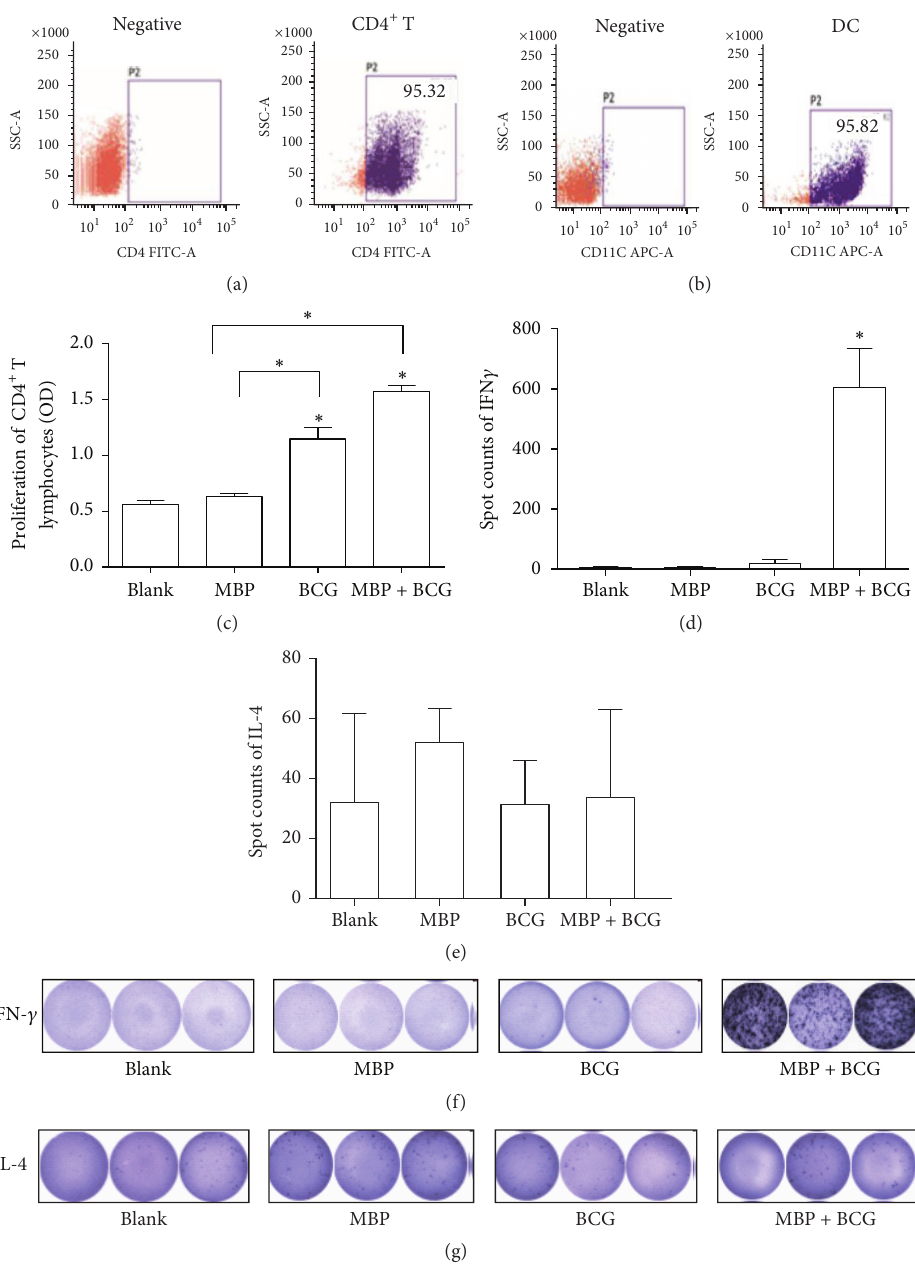
Figure 1: The activation of CD4 + T cells induced by the combination of MBP and BCG. (a) Isolation of CD4 + T cells from spleen samples from normal mice. The CD4 + T cell purity was analyzed by flow cytometry. (b) Dendritic cells were isolated from the spleen, and the percentage of dendritic cells purified was measured by FACS analysis. (c) MBP and BCG synergistically increased the proliferation of CD4 + T cells cocultured with DCs. All experiments were repeated three times, and all the data are expressed as the mean ± SD ( 𝑛 = 3 ). ∗ 𝑃 < 0.05 was consideredsignificant,comparedwithBlankgrouporwithMBPgroup.(dande)TheproductionofIFN- 𝛾 andIL-4inCD4 + Tcellscocultured with DCs, as detected by ELISPOT. CD4 + T cells were cocultured with DCs at a ratio of 100: 1. (f and g) Spots were counted by an ELISPOT